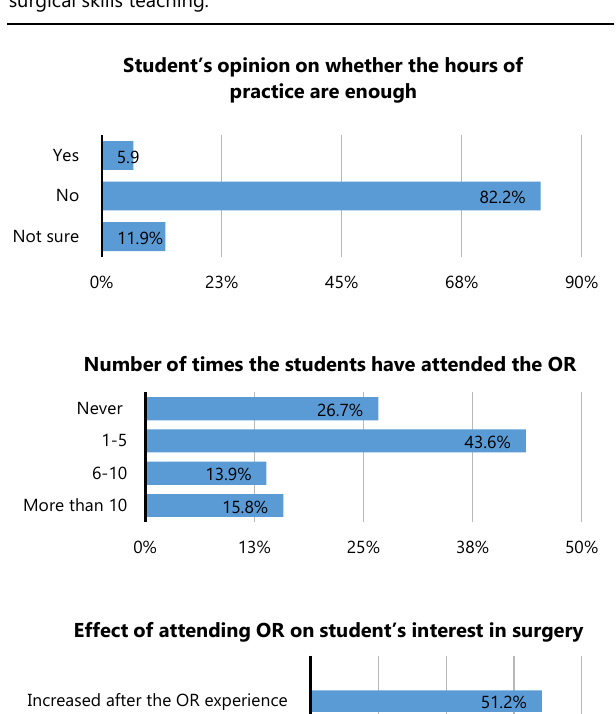
Figure 1 . Interest in surgery at the beginning of students’ medical education compared with the time of the survey.